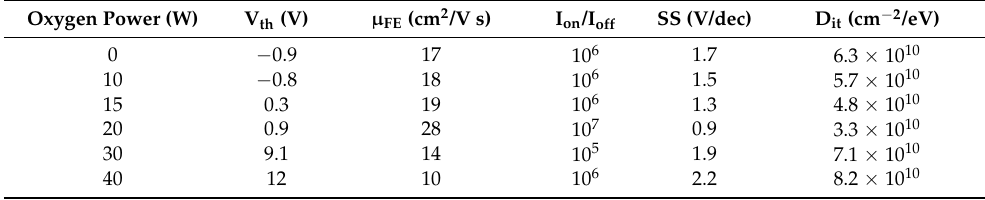
Table 3. Electrical parameters of a-InGaZnO:O TFTs with differently powered oxygen plasma. Oxygen Power